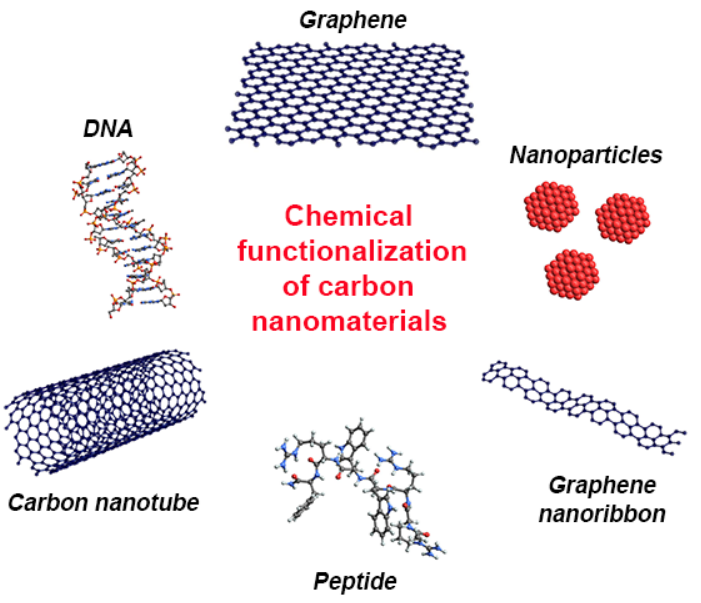
Figure 1. A schematic representation of different types of chemical functionalization of